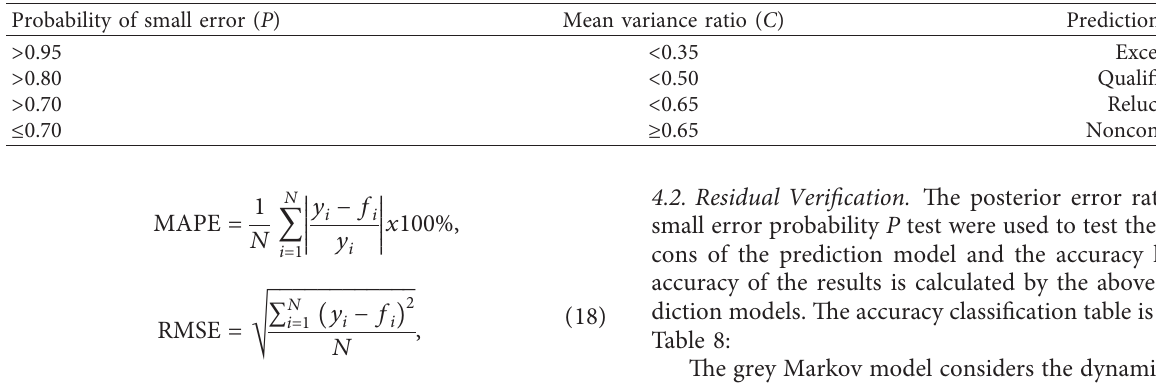
Table 8: Classification table of prediction